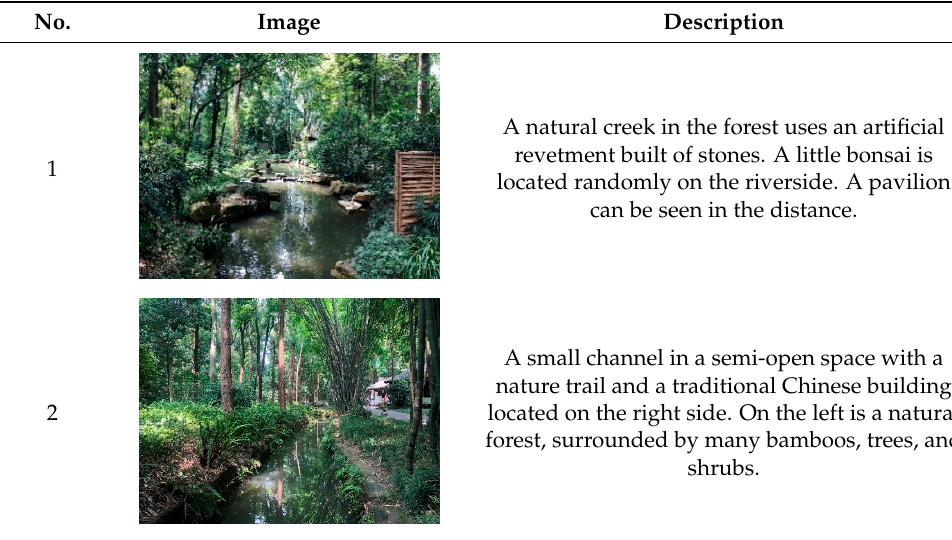
Figure 1. The location of Huanhuaxi Park. Table 1. Description of the 10 urban park blue spaces.